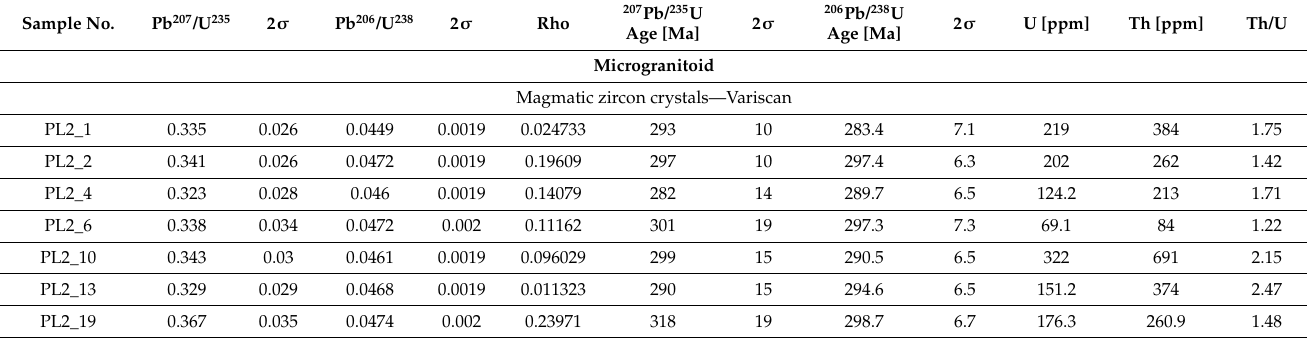
Figure 5. Cathodoluminescence (CL) images of zircon crystals from the microgranitoid ( a )—Pl 2, apatite from microgranitoid ( b )—PL 2 and andesite ( c )—And from Pluskawka. Analytical spots and analyses numbers (see Table 5) are marked as circles. Table 5. LA-MC-ICP-MS U–Pb zircon data from Pluskawka microgranite and andesite. Sample